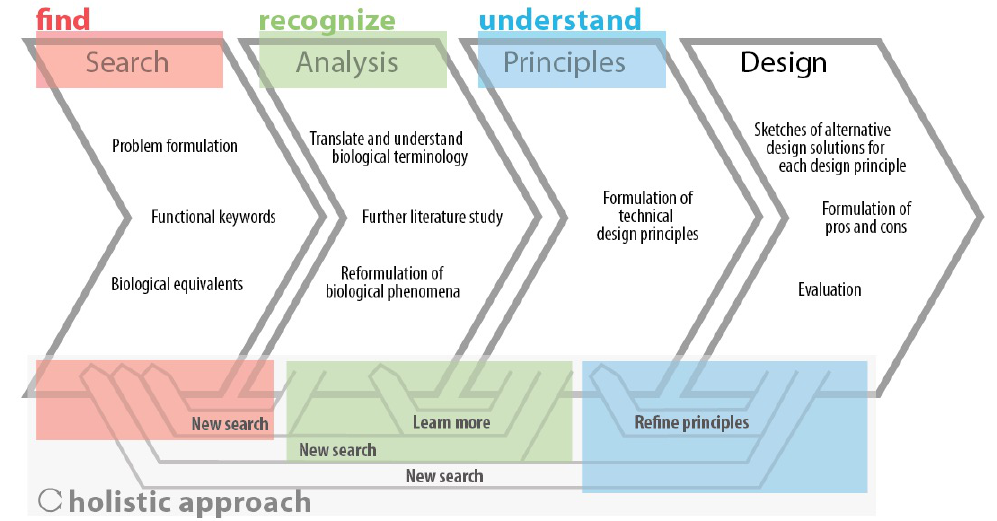
Figure 2. Holistic approach to biomimetics, through supporting identification, selection and analysis by addressing the findability, recognizability and understandability of information. Design process adapted from Lenau